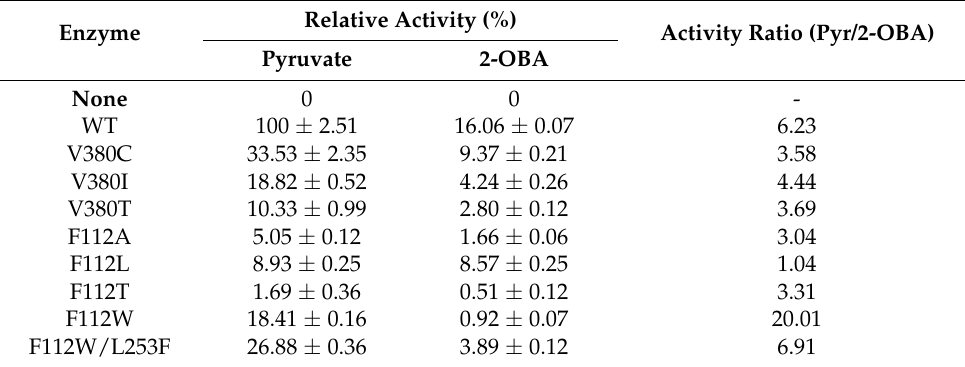
Table 2. Relative activities of PoxB and its variants with pyruvate or 2-OBA.